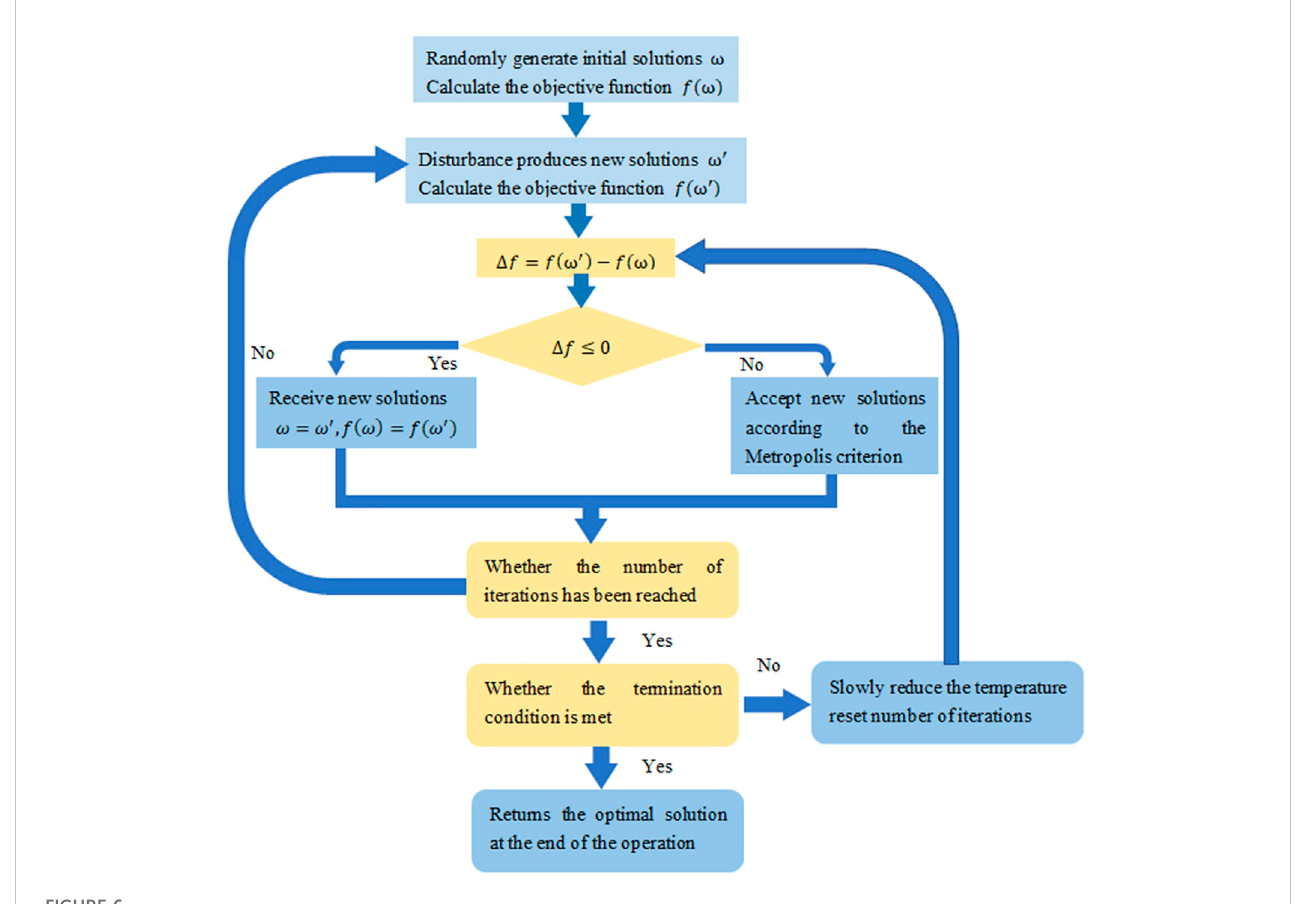
FIGURE 6 Basic concept of